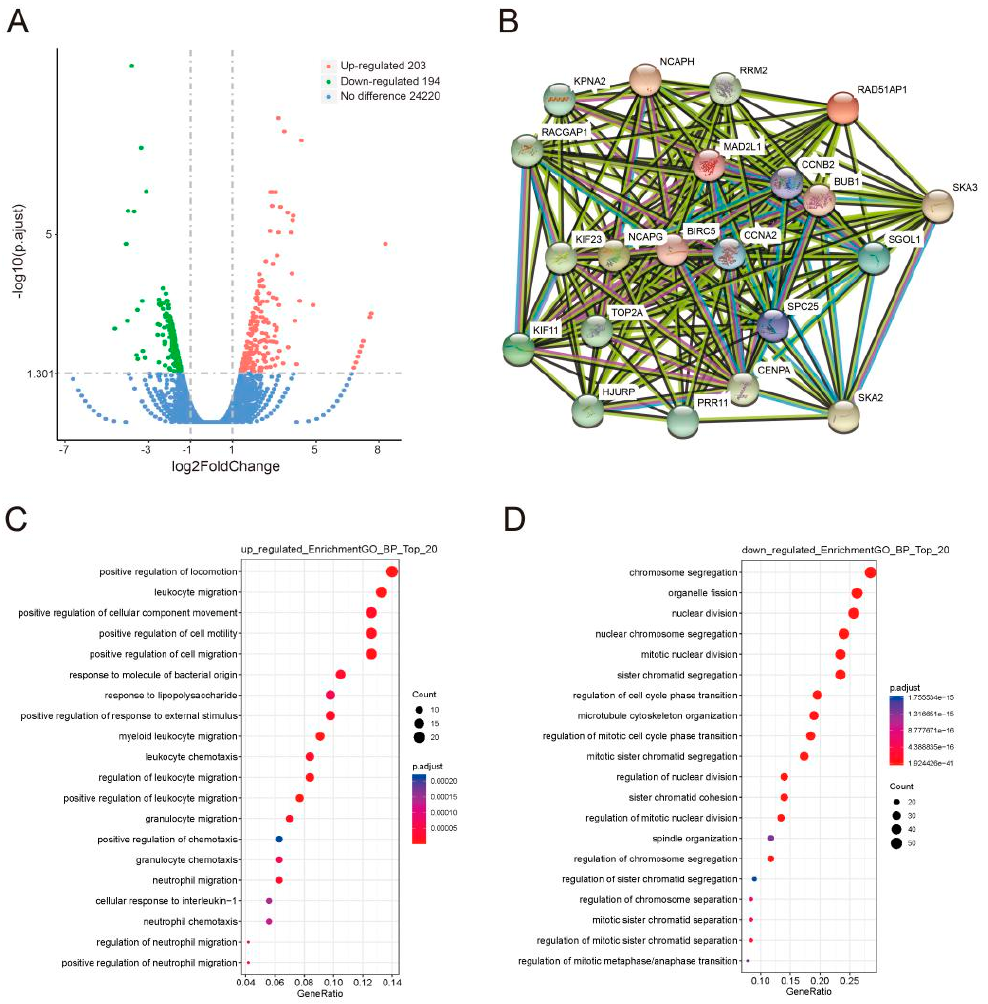
Figure 6. Identification and functional categories of differentially expressed genes associated with GLI1/2 inhibition. ( A ) Volcano plot of the gene expression profile. The red dots and the green dots represent upregulated genes and downregulated genes, respectively. ( B ) The protein–protein interaction network of 19 downregulated genes relating to the PRR11-SKA2 gene pair was built via the String database. ( C , D ) GO enrichment analysis of differentially expressed genes. The top 20 biological processes enriched in the upregulated genes ( C ) and the downregulated genes ( D ) are shown on the y-axis.